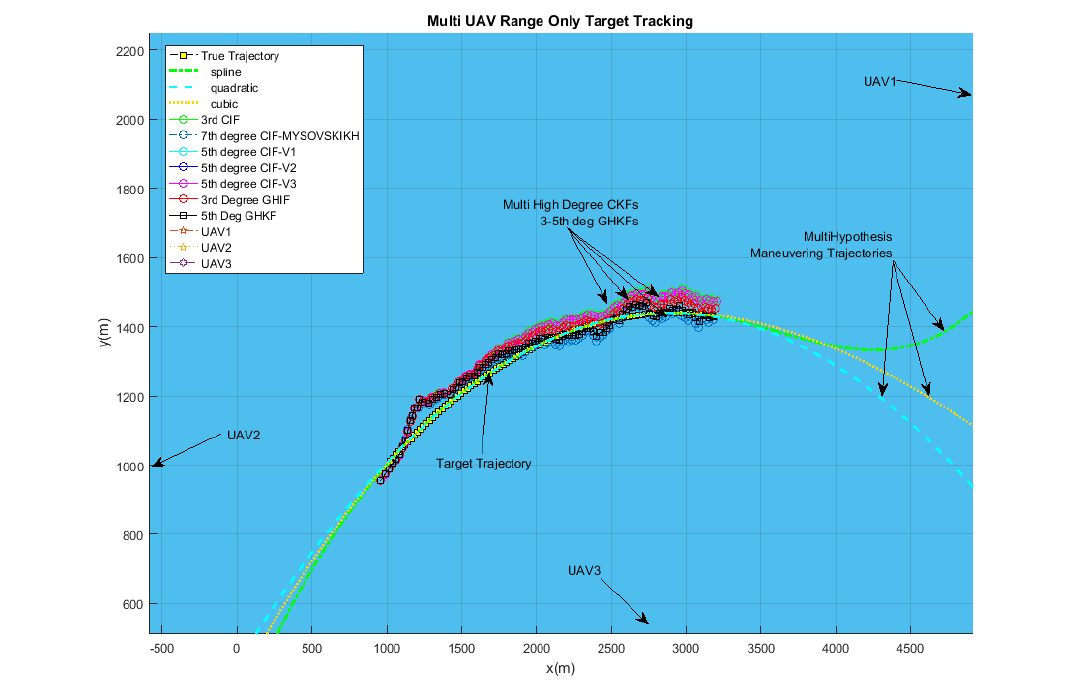
Figure 12. Larger view of range-only Doppler-based estimation: Results of 7 th -degree CIF, 5 th -degree CIF, 5 th -degree GHIF, 3 rd -degree GHIF compared to multiple reference trajectories (spline, quadratic,